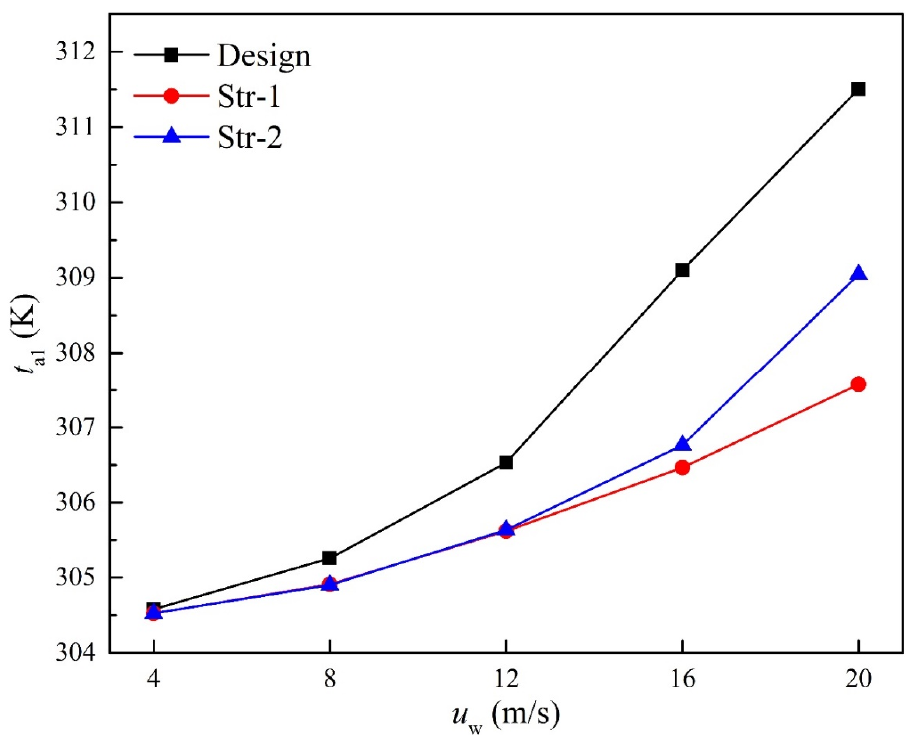
Figure 10. Average inlet air temperatures of ACCs for Design, Str-1, and Str-2 cases under windy conditions.